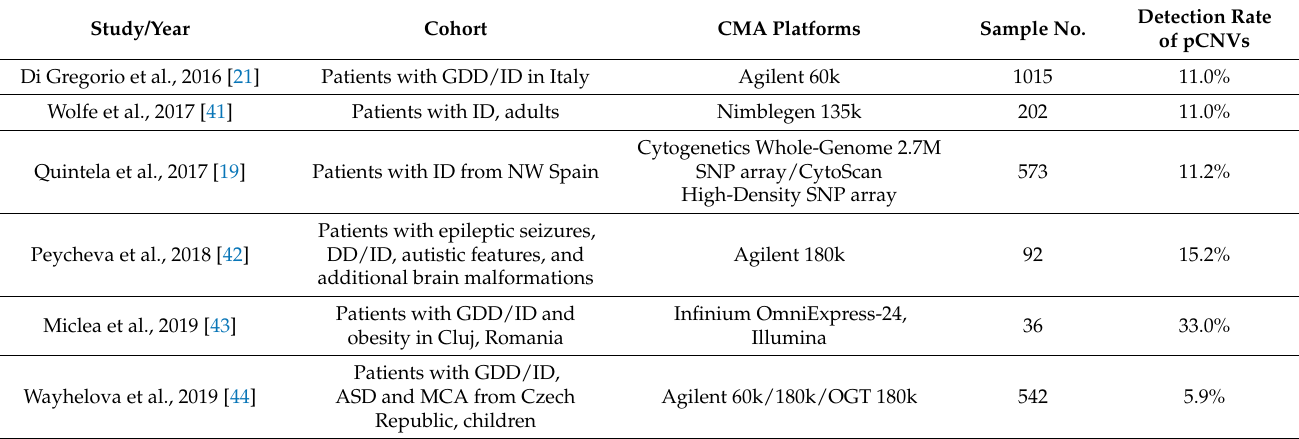
Table 3. Diagnostic yields from recent studies that used chromosomal microarrays for diagnostic testing in European cohorts of individuals diagnosed with syndromic or non-syndromic GDD/ID. CMA Platforms Sample